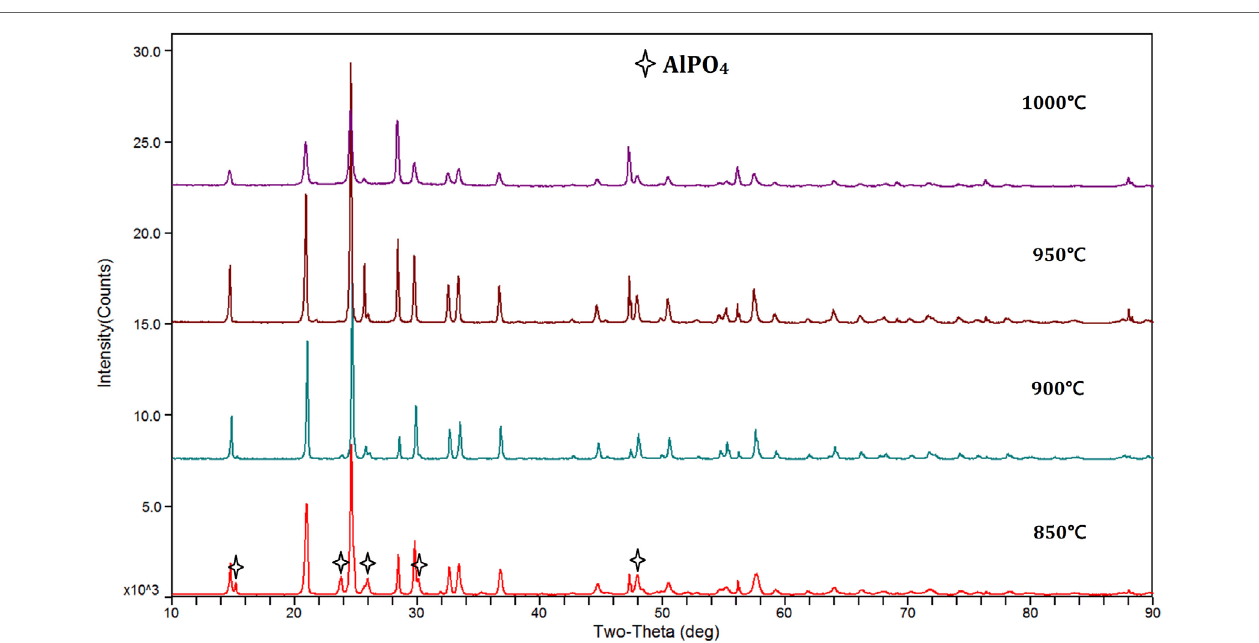
FigUre 1 | XrD patterns of li 1.5 al 0.5 ge 0.2 Ti 1.3 (PO 4 ) 3 sintered at various temperatures